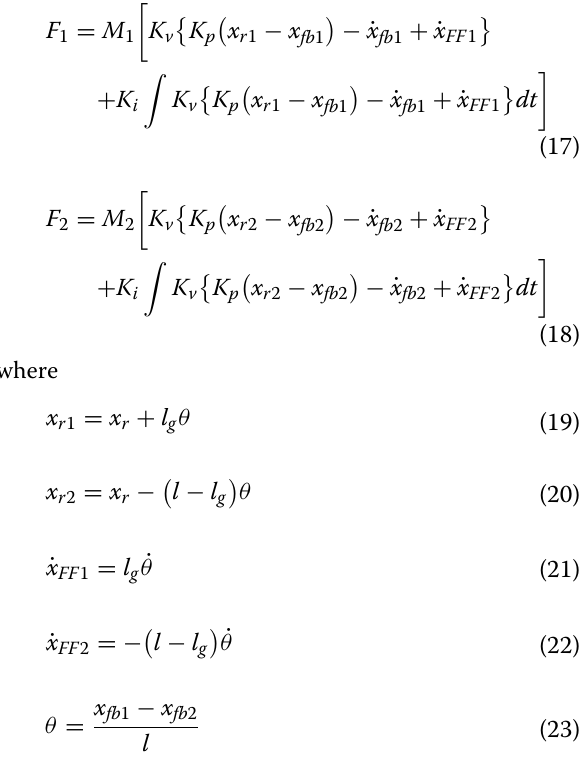
Tables 1 and 2, l g is distance between Table 1 and center of the mass, and θ is rotation angle. Other parameters have the same meaning as in control method 1. Control method 2 is based on the P-PI control. Hence, it consid- ers θ but has no control over it, paying closer attention to the work-point position on the top bar of the linear motor slider, which in general is the center-of-mass of the top bar. Figure 11 shows block diagram of control method 2.